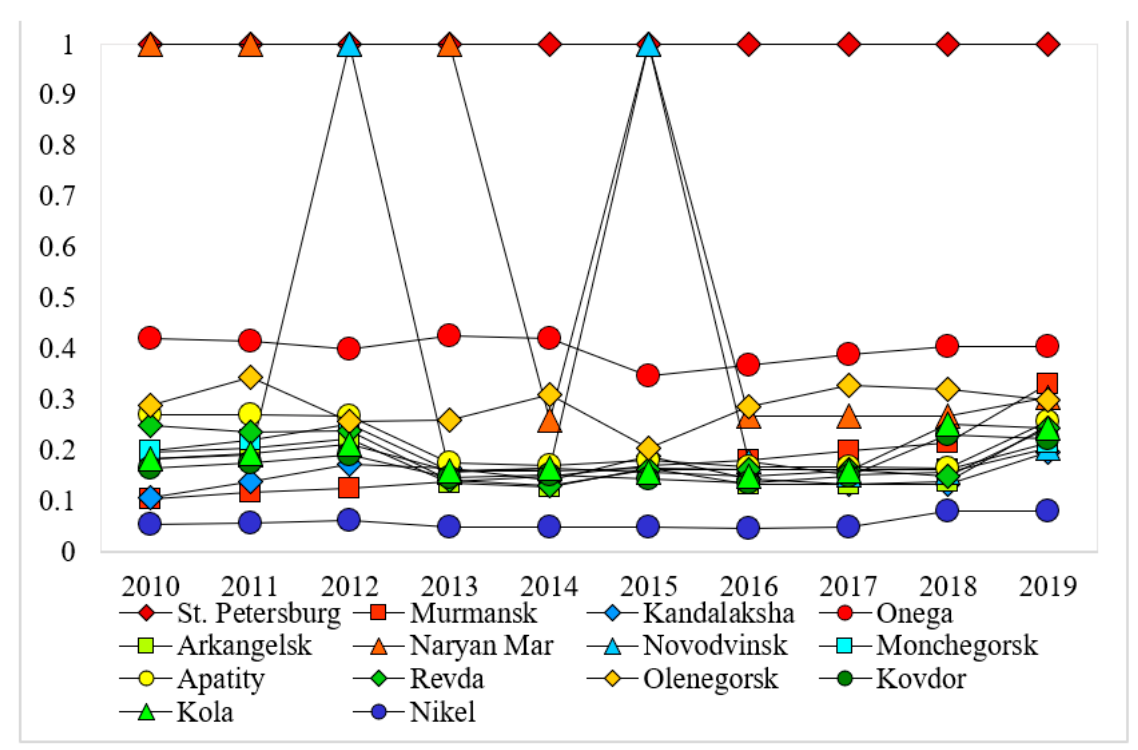
Figure 2. Variations in eco ‐ efficiency scores of cities along the western section of the NSR across the years 2010–2019.